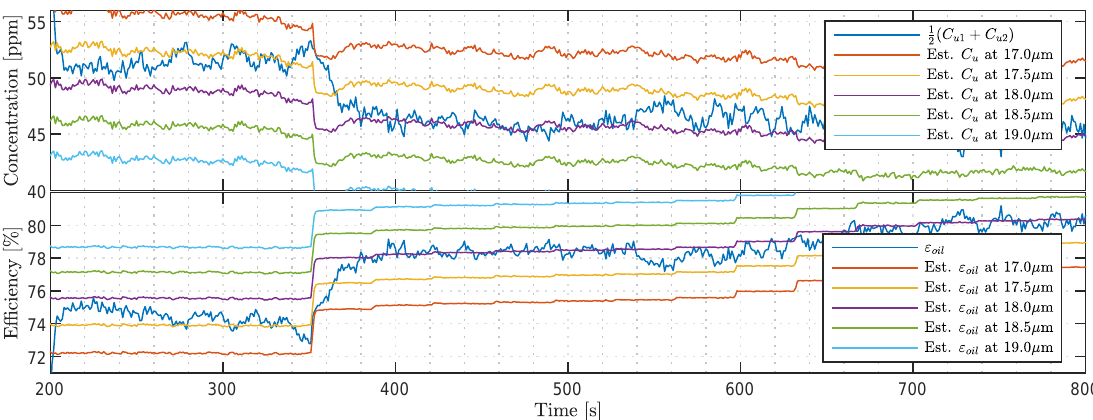
Figure 21. Stepping time-window where V o steps from 0.5–97% open. As V o opens, F s increases, C u decreases, and ε oil increases as C i is nearly constant. The model is given five different log-normal inlet droplet size distributions during this experiment with mean values from 17–19 µm and all with variance 0.0005 µm 2 .